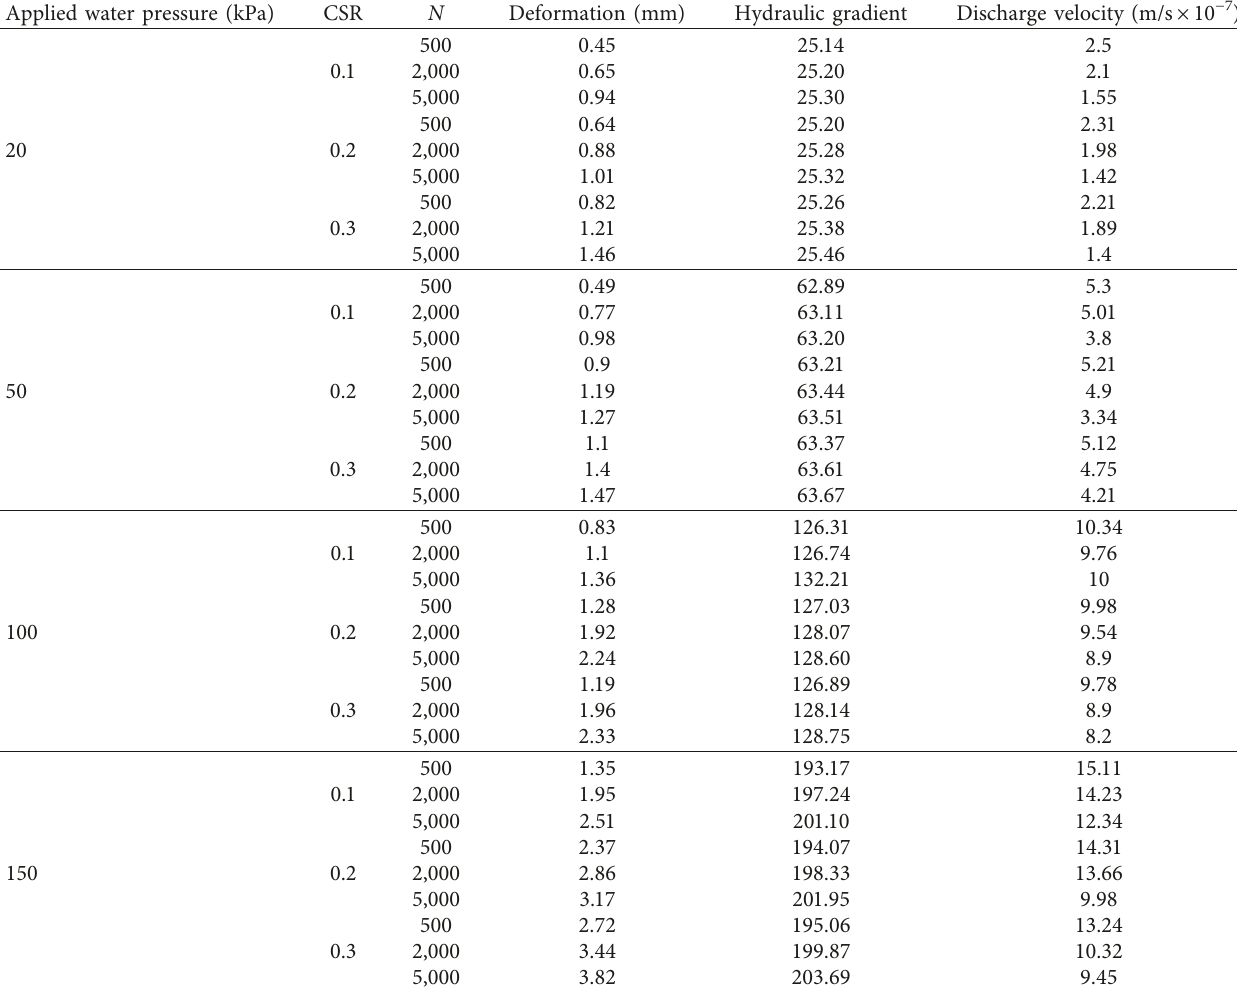
Table 3: Calculated values of the hydraulic gradient and discharge